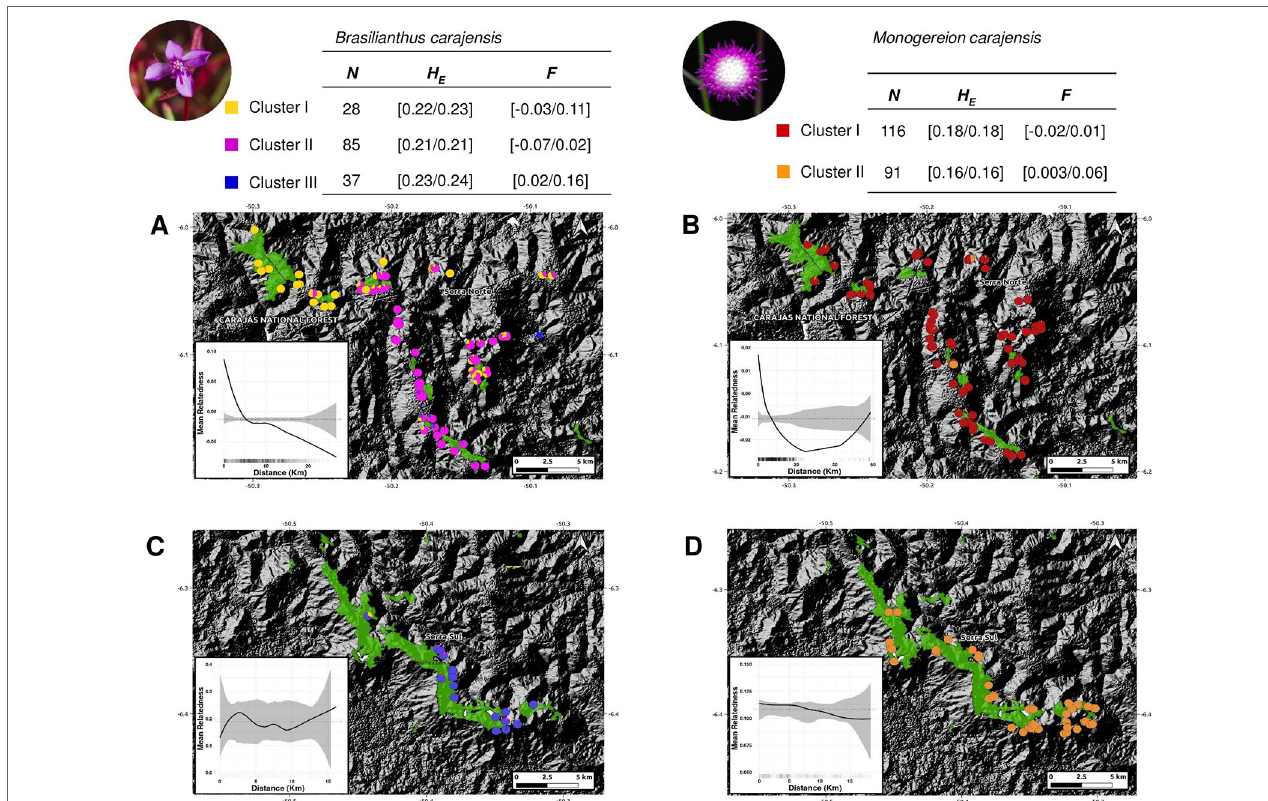
FiGURE 2 | Map showing the ancestry coefficients from Brasilianthus carajensis ( A and C ) and Monogereion carajensis ( B and D ) in Serra Norte (upper panels) and Serra Sul (lower panels) determined using the Admixture software. Montane savanna areas are shown in green against hill shade layers. Smaller lower-left corner plots show spatial autocorrelation in genetic relatedness, where black solid lines are the LOESS fit to the observed relatedness, gray shaded regions are 95% confidence bounds around the null expectation (black dotted lines), and short vertical lines at the bottom of the figure are observed pairwise distances. Genetic diversity measures for each genetic cluster are shown in the upper tables. Sample sizes (N) are followed by mean expected heterozygosity ( H E ) and mean inbreeding coefficient ( F ), and values represent 95% confidence intervals.